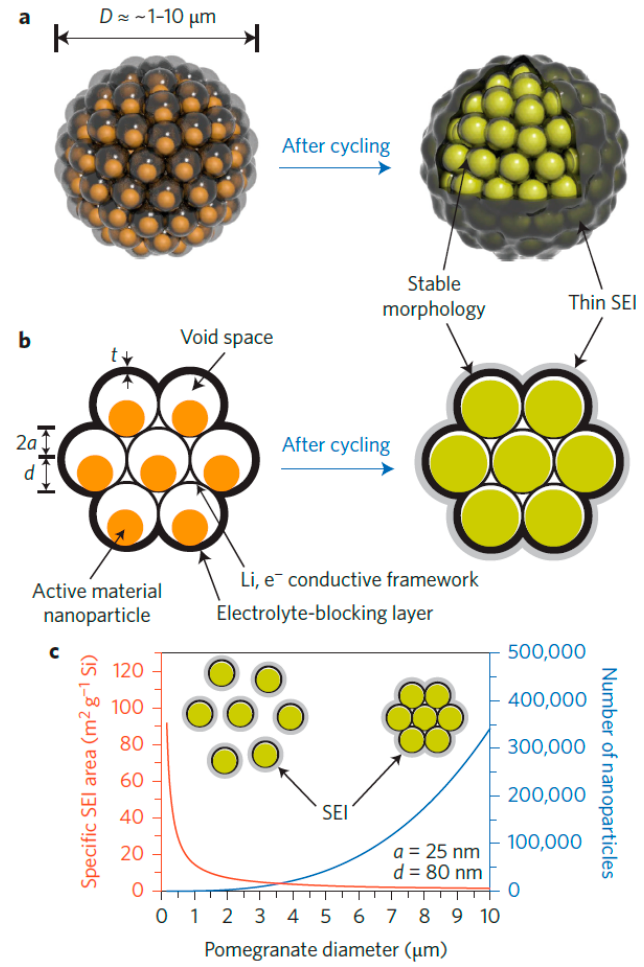
Figure 14. The schematic of the pomegranate-inspired Si anode design in ( a ) 3D and ( b ) 2D before and after cycling (in the lithiated state); ( c ) The variation of the specific SEI area and the number of primary nanoparticles in one pomegranate particle versus its diameter. Adapted with permission from [149], © Nature Publishing Group, 2014.